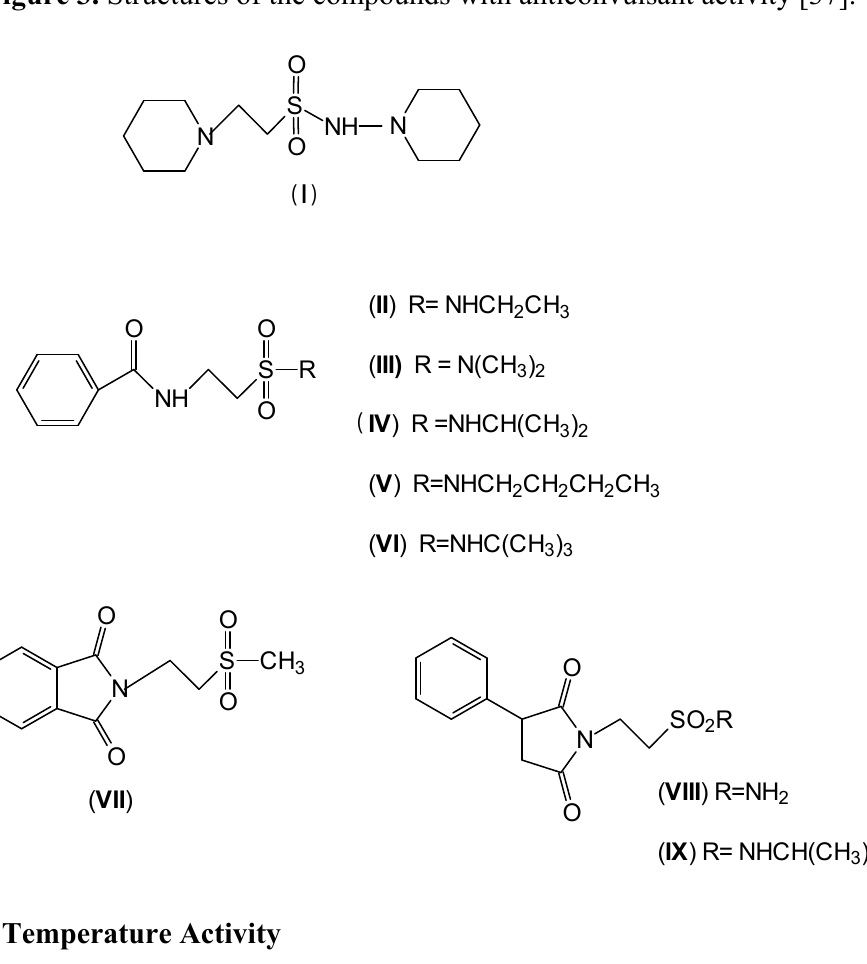
Figure 3. Structures of the compounds with anticonvulsant activity